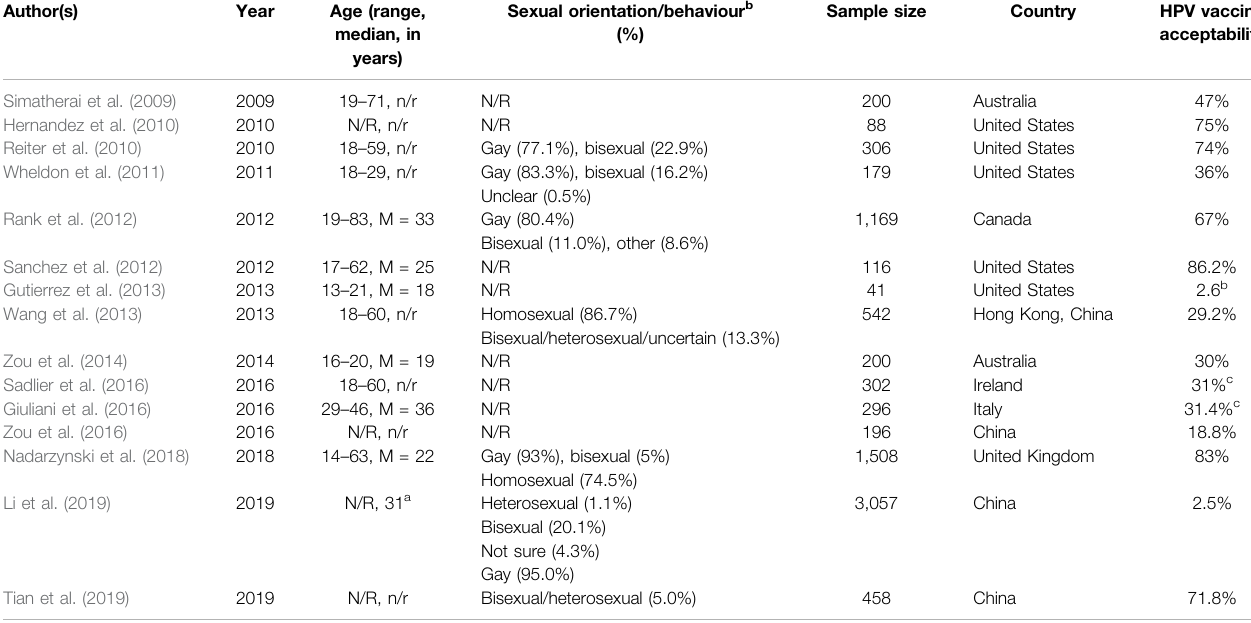
TABLE 2 | Studies addressing human papillomavirus (HPV) vaccine acceptability, study characteristics, and risk of bias, ordered by publication